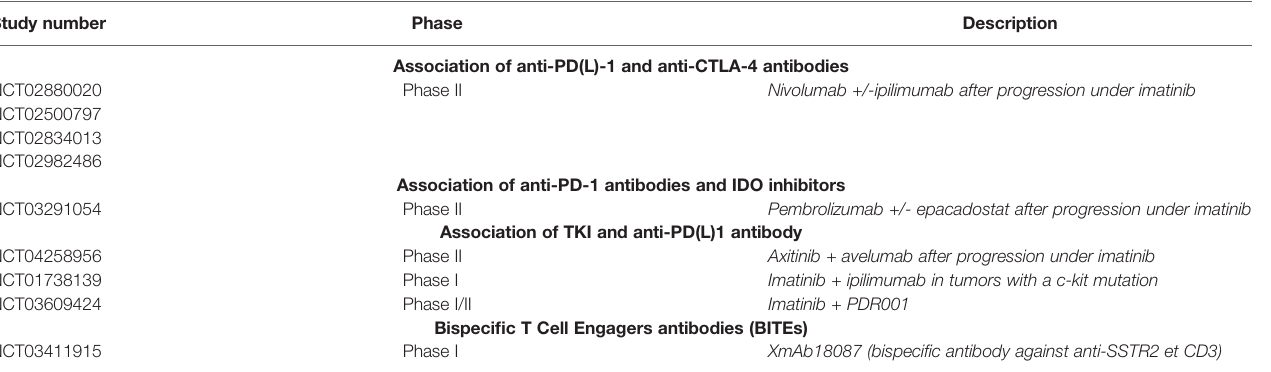
TABLE 4 | Ongoing studies of immunotherapy in gastrointestinal stromal tumors. Study